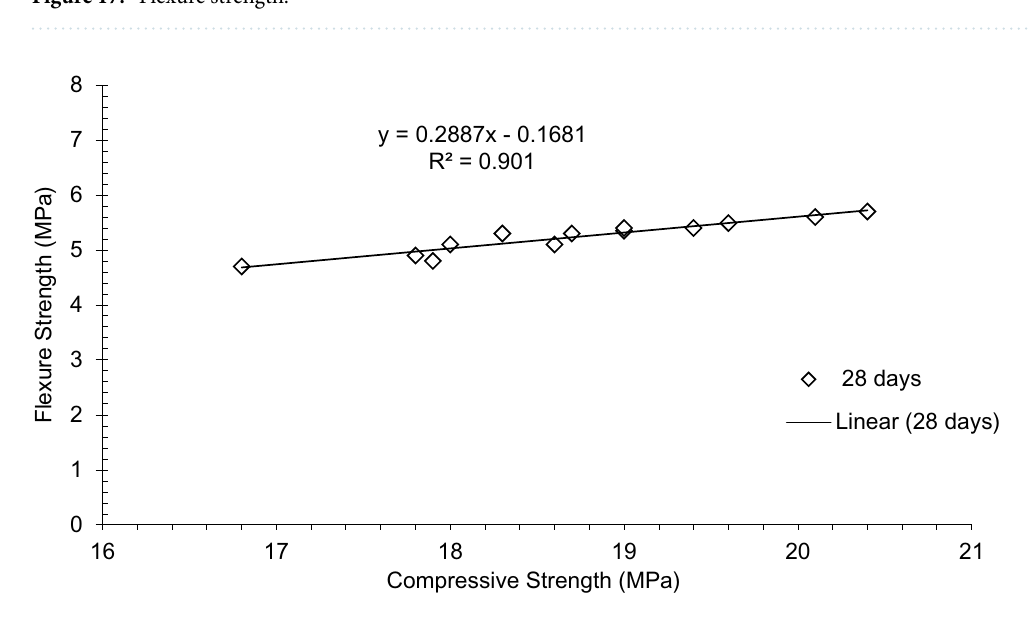
Figure 17. Flexure strength.